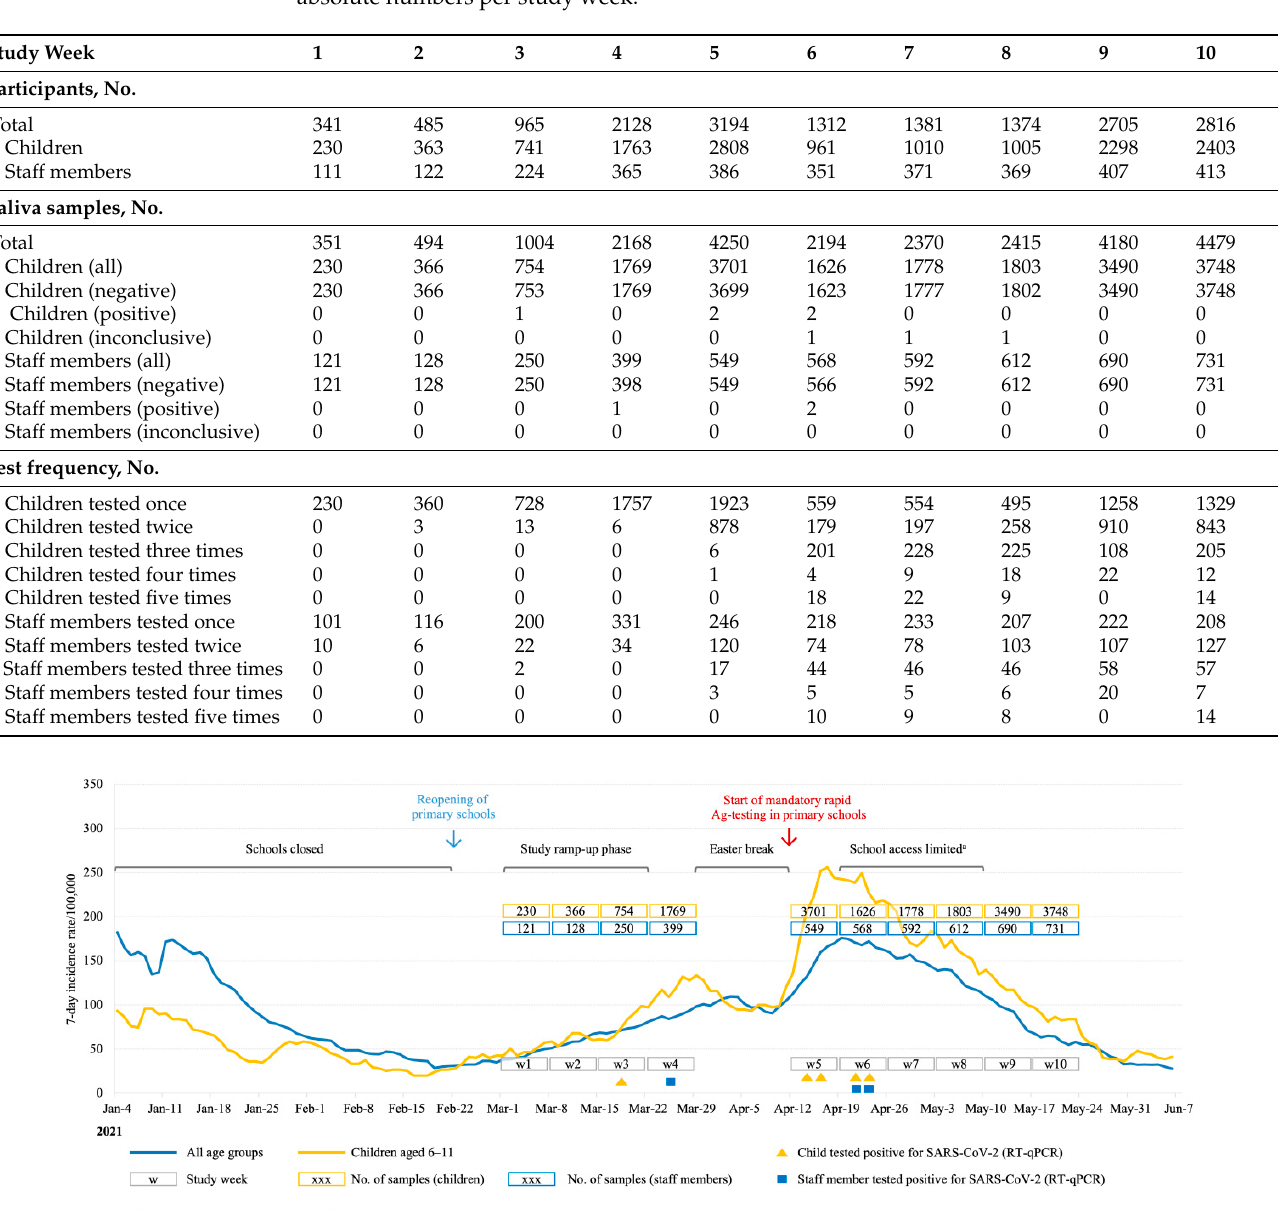
Table 2. Participants, saliva samples and test frequency per study week. Data are presented as